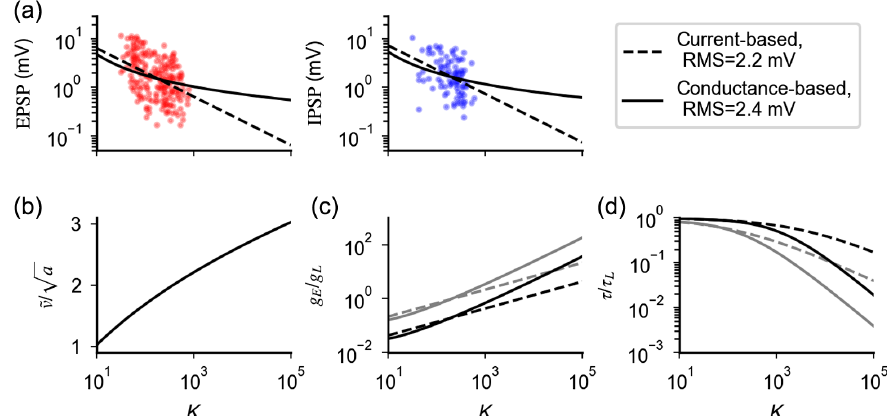
FIG. 5. Comparison of predictions given by current-based and the conductance-based models in describing experimental data from cultures. (a) Strength of excitatory (EPSP) and inhibitory (IPSP) postsynaptic potentials recorded in Ref. [63] are compared with best fits using scaling relationships derived from networks with current-based synapses (dashed line) and conductance-based synapses (continuous line). Root mean square (rms) and best fit parameters are rms ¼ 2 . 2 mV, g ¼ 1 . 1 , and J 0 ¼ 20 mV for the current-based model and rms ¼ 2 . 4 mV, g ¼ 3 . 4 , and ¯ v ¼ 0 . 08 for the conductance-based model. (b) Value of ¯ v= based model as a function of K . (c) Ratio between excitatory and leak conductance as a function of K , for ν ν ν 5 spk = s (gray) obtained with a rescaled as Eq. (14) (continuous line) and as 1 = (black) and ν E ¼ I ¼ X ¼ between τ and τ as a function of K ; parameters and scaling as in L